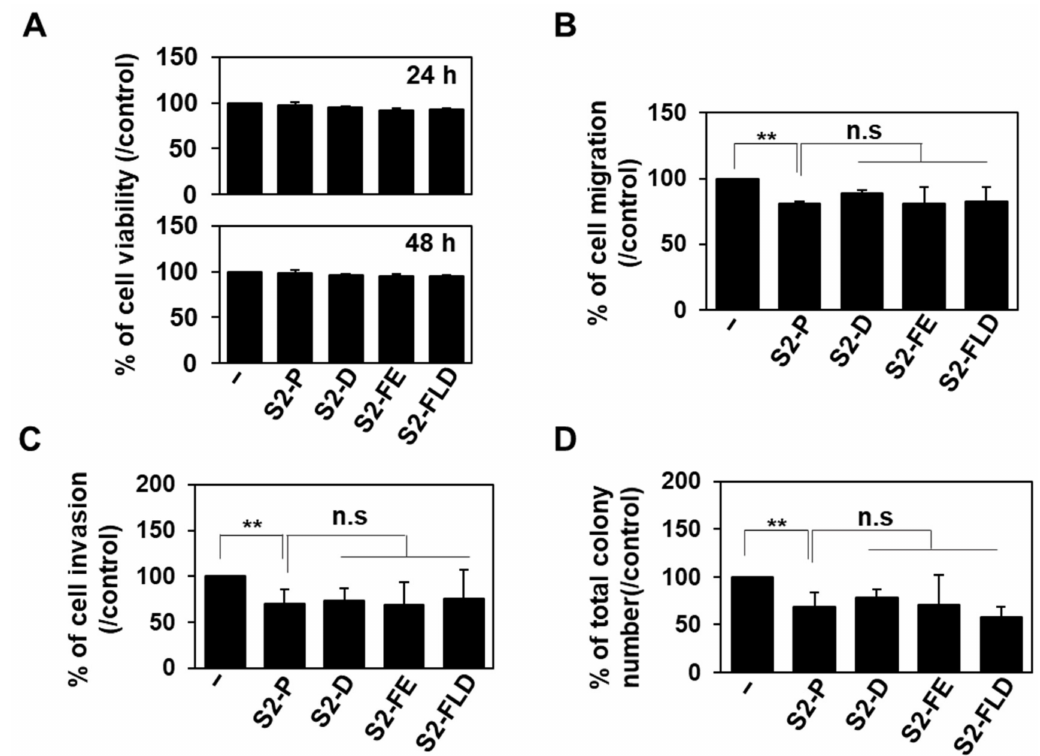
Figure 4. The synthetic peptides inhibited the tumorigenic activity of HT29-SDC2 cells. ( A ) The proliferation of HT29-SDC2 cells was evaluated with the MTT assay as described in the ‘Materials and Methods’ section. Data are shown as the average value ± S.D. of three independent experiments carried out in triplicate. ( B ) Transwell migration assays were performed with HT29-SDC2 cells treated with 50 nM of the peptide, with 10% FBS used as a chemoattractant in the lower chamber. Cells (1 × 10 6 ) were allowed to migrate on gelatin-coated (10 µ g/mL) transwell plates for 24 h. Data are shown as mean ± S.D. ( n = 3); n.s, no significant; **, p < 0.01 versus HT29-SDC2 control cells or S2-P treated HT29-SDC2 cells. ( C ) For the invasion assay, cells were loaded to the upper compartments of Matrigel-coated (30 µ g/mL) plates, incubated for 24 h, and fixed and stained with 0.6% hematoxylin and 0.5% eosin. The number of migrated or invasive cells was counted. Data are shown as mean ± S.D. ( n = 3); n.s, no significant; **, p < 0.01 versus HT29-SDC2 control cells or S2-P treated HT29-SDC2 cells. ( D ) HT29-SDC2 cells (2 × 10 5 /dish) were seeded in soft-agar plates and allowed to grow for 14 days, and the viable colonies were counted. Data are shown as mean ± S.D. ( n = 3); n.s, no significant; **, p < 0.01 versus HT29-SDC2 control or S2-P treated HT29-SDC2